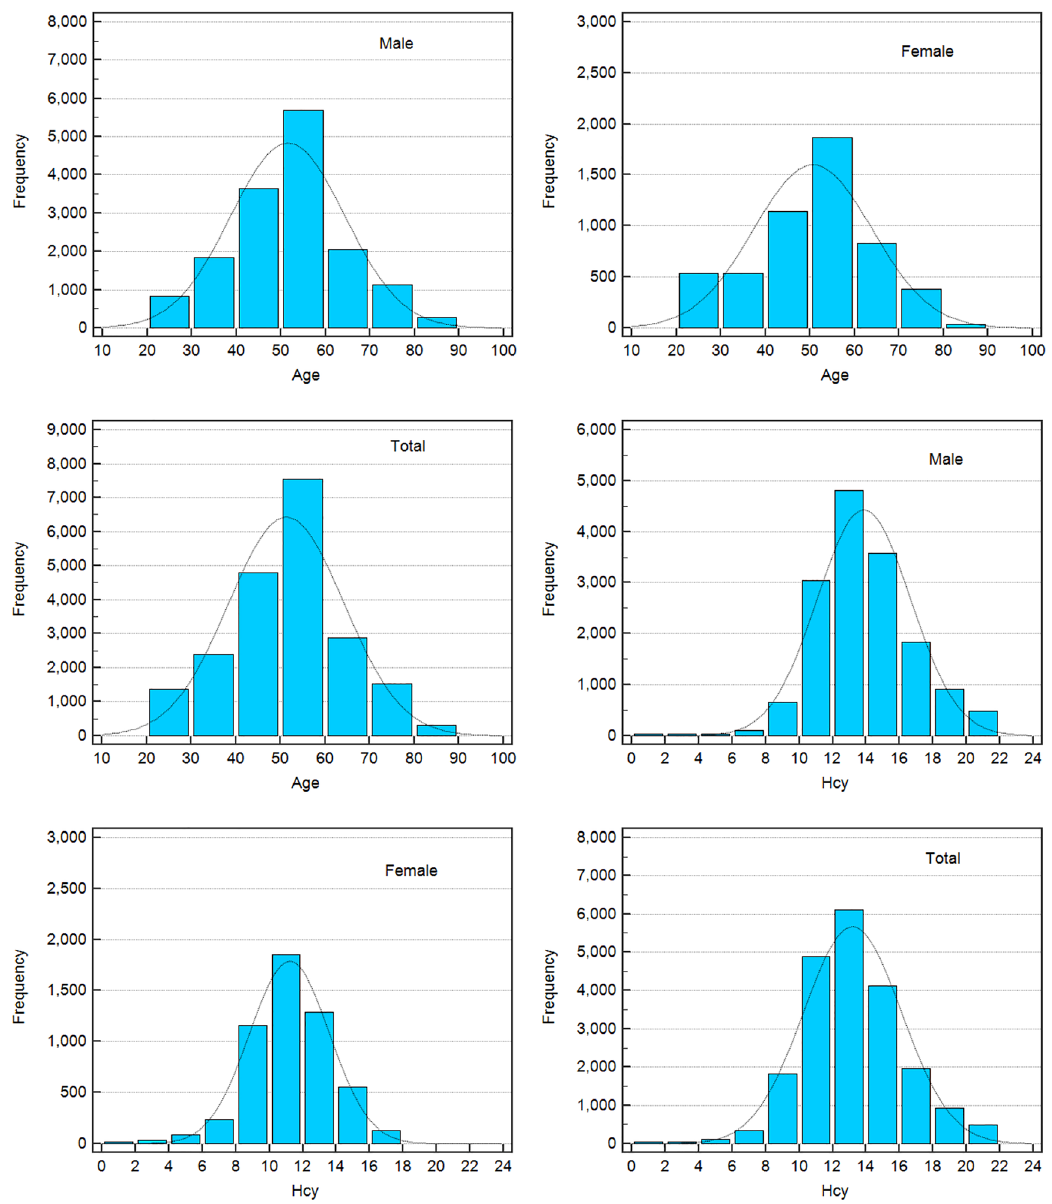
Figure 1: Histograms of homocysteine (Hcy) and age in subjects. The unit of Hcy is